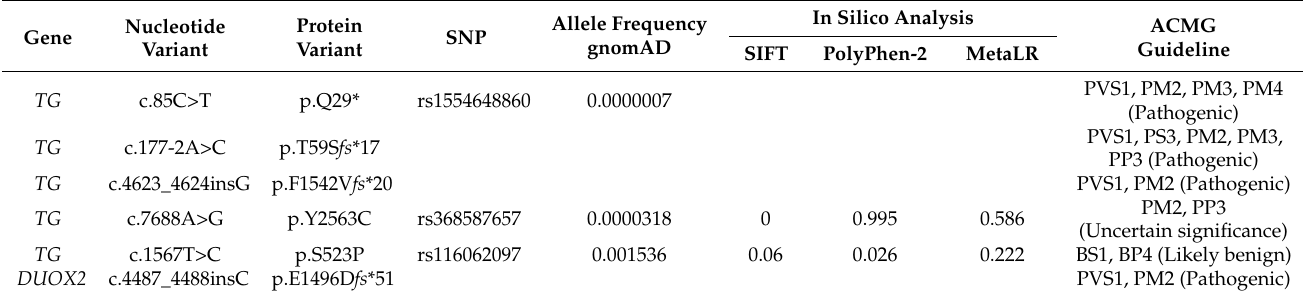
Table 2. Overview of genetic variants and in silico analysis of missense